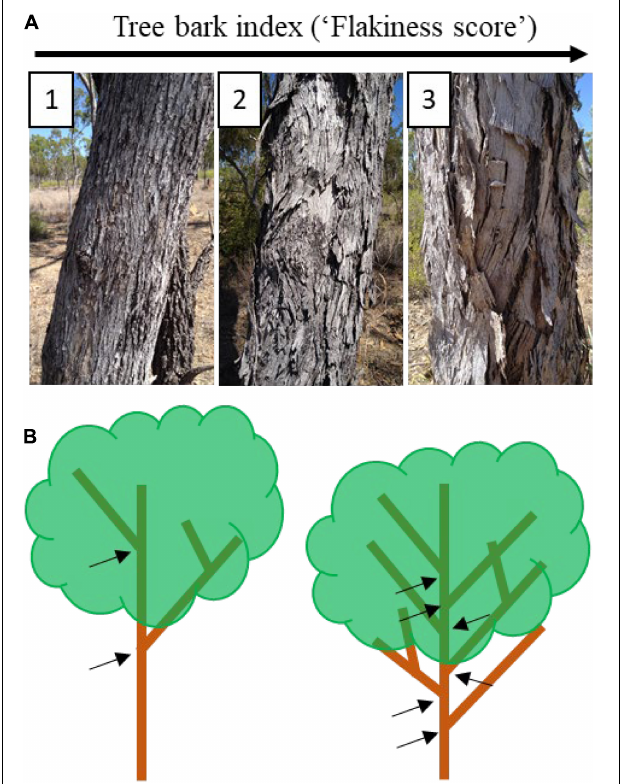
FIGURE 2 | Microhabitat complexity measures, with tree bark index ( A : “flakiness score”) ranging from 1 (not flaky, no peeling bark, tight braided fissures and very few sheltering options for geckos) to 3 (very loose and flaky or peeling tree bark with multiple areas for refugia; tree branch complexity (B) , with only two major branches coming from the main trunk (black arrows; left) compared to a more complex tree with more branching complexity with six branches coming off the main trunk (right).